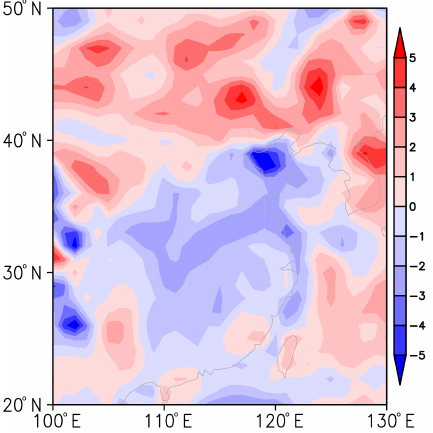
Figure 6. The difference of averaged wintertime PBLH between 2014 and 2010.